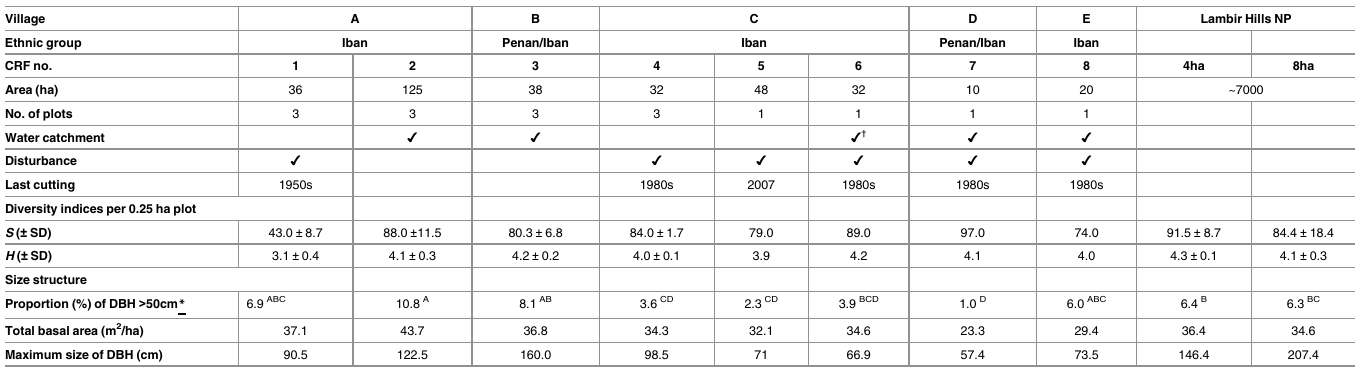
Table 1. Diversity indices and size structure of CRFs. The species richness ( S ) and Shannondiversity index ( H ) were standardized for the plot area.